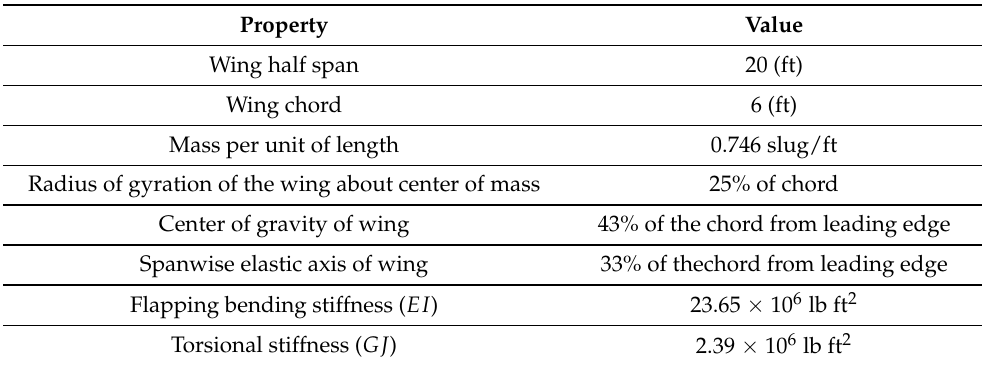
Table 2. Properties of the Goland